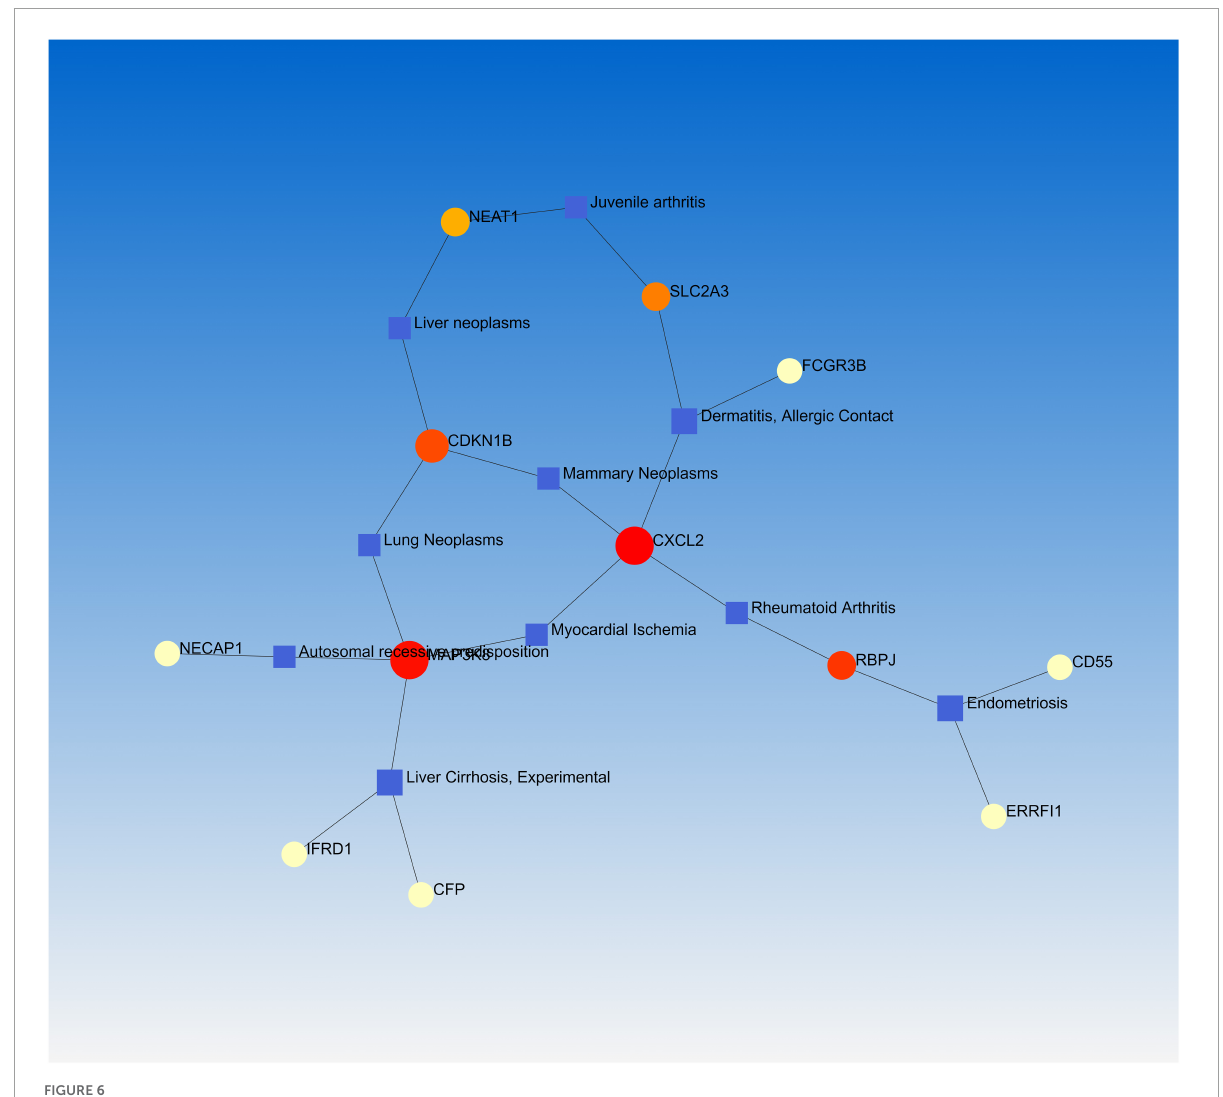
FIGURE6 The gene-disease association network represents diseases associated with mutual DEGs.